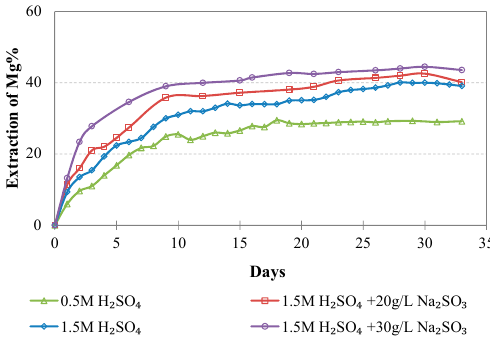
Figure 8. Evolution of % Mg extraction vs time during LAI leaching for different tests.